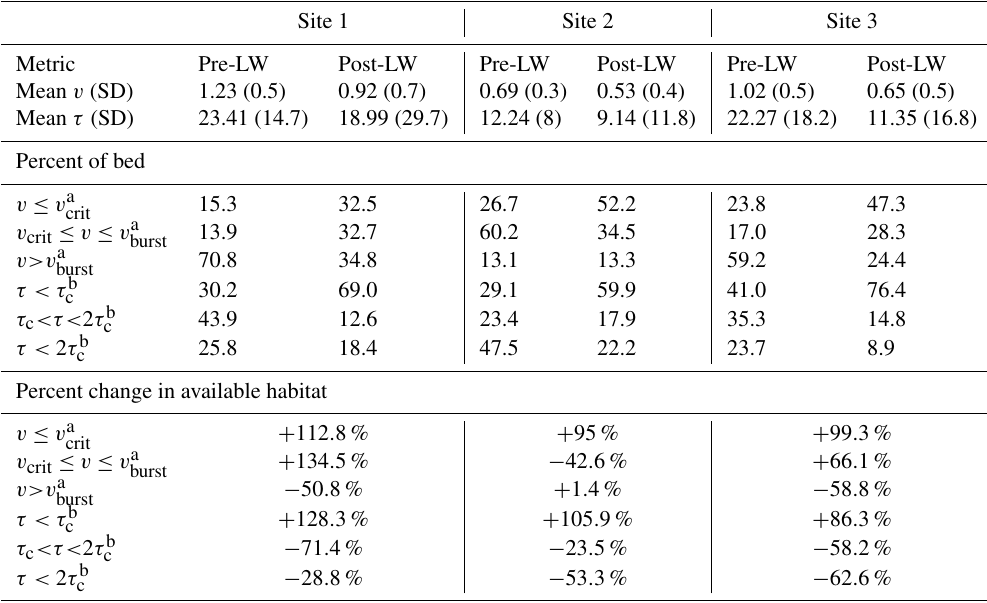
Table 3. Mean and standard deviation (SD) of velocity ( v ) and shear stress ( τ ) at bankfull flow ( Q bf ) pre- and post-LW at the three study sites; Q bf modeling results for habitat metrics v and τ expressed as a percentage of the channel bed pre- and post-LW; and percentage change in available fish habitat.